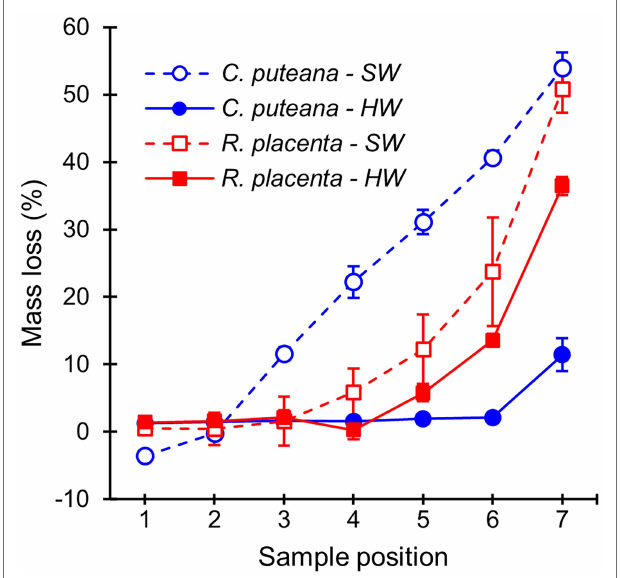
FIGURE 2 | Average mass losses of Scots pine sapwood (SW) and heartwood (HW) blocks due to C. puteana and R. placenta . Error bars represent ±SD. N =